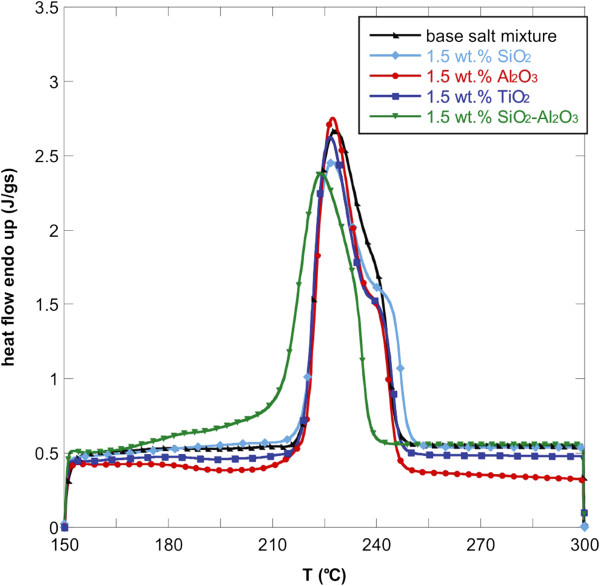
Heat flow versus temperature for NaNO3-KNO3 binary salt mixture and nanofluids (1.5 wt.% of oxide nanoparticles).